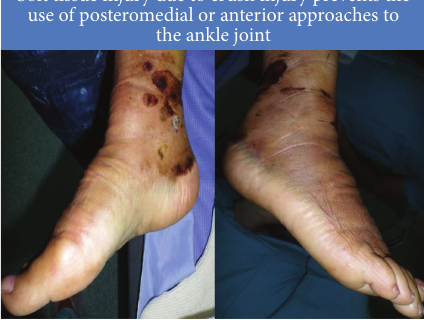
Figure 1: Following a crush of the leg, despite two weeks of elevation and compression therapy, the anterior and posteromedial approaches are fraught with risk due to extensive soft tissue injuries.